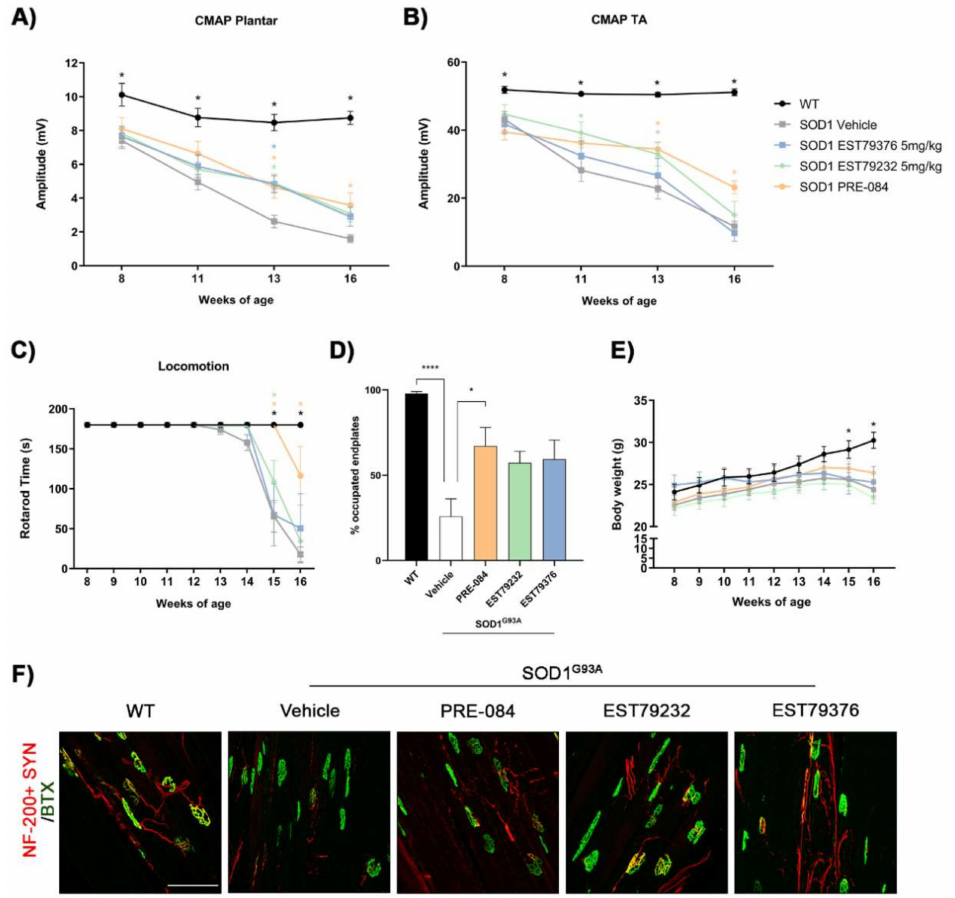
Figure 4. Effects of administration of EST79232 and EST79376 on disease progression of SOD1 G93A mice. ( A , B ) Plots of the CMAP amplitude of plantar and tibialis anterior (TA) muscles. I EST79232 treatment produced a slight improvement in the rotarod performance in treated SOD1 G93A mice ( n = 9 SOD1 vehicle, n = 7 SOD1 EST79232, n = 5 SOD1 EST79376, and n = 5 SOD1 PRE-084 mice). ( D ) Histological analyses of NMJ showed a tendency to maintain the proportion of occupied endplates in the GM muscle of treated SOD1 G93A with the two novel Sig-1R ligands compared to vehicle group ( n = 5 per group). ( E ) Plot of the body weight of the different groups of mice during the follow-up. At 15 and 16 weeks, there was a significant difference between SOD1 G93A mice and wild-type (WT) mice. ( F ) Representative confocal images of NMJ in the GM muscle of WT mice and SOD1 G93A male mice with or without Sig-1R ligands treatment at 16 weeks of age. Scale bar: 100 µ m. Data are mean ± SEM, analyzed with one-way ( D ) or two-way ( A – C , E ) ANOVA with Bonferroni’s multiple comparisons test. **** p < 0.0001, * p < 0.05 vs. SOD1 G93A